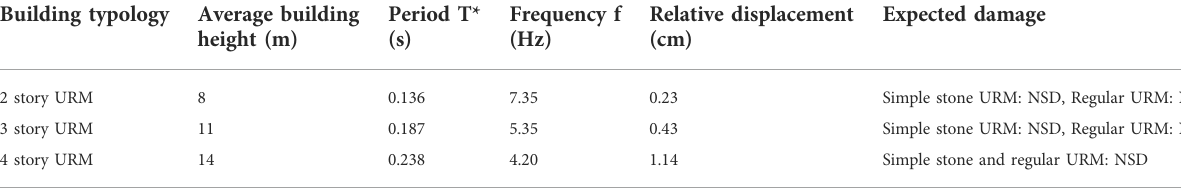
TABLE 4 Damage assessment for different building typologies for Visso (2-4 story URM